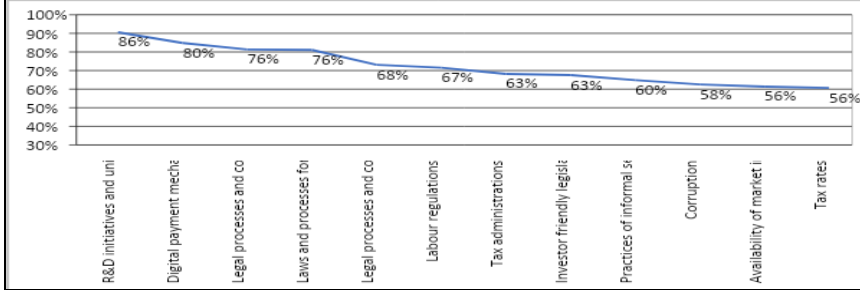
Figure 18 Rating Elements of Policy and Business Environment Pitfalls